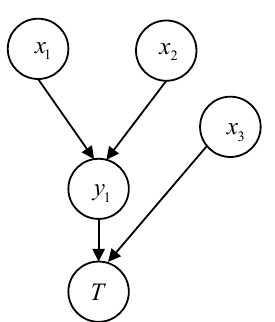
Figure 4. Block diagram of principle of the super heterodyne receiver.